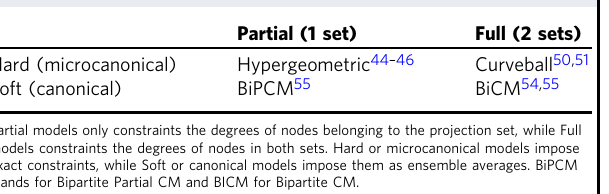
Table 1 Classi fi cation of con fi guration models (CM) for bipartite network projections by number and type of